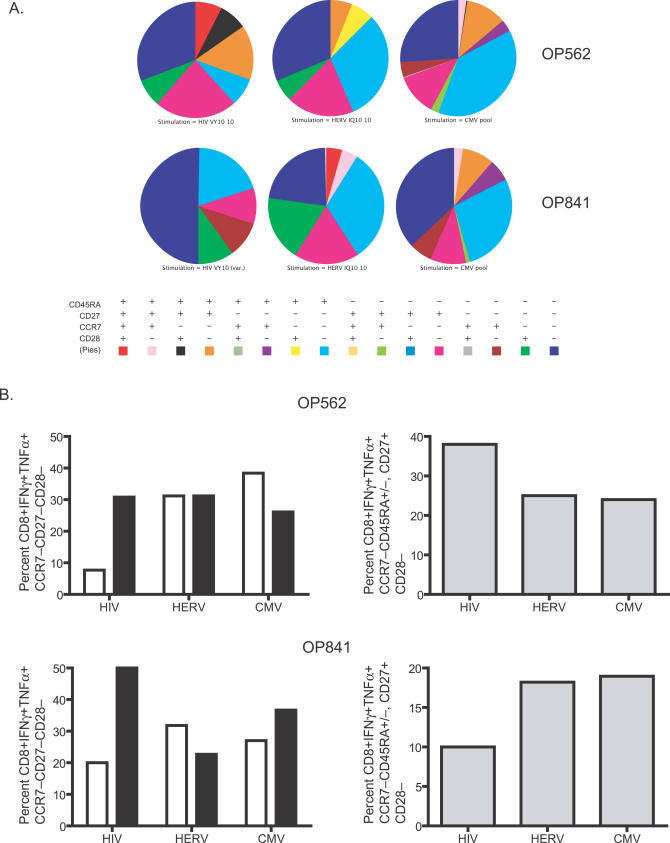
Phenotypic Profile Comparison of HIV-1-, HERV-, and CMV-Specific T Cells Measured by Multicolor Cytokine Flow Cytometry(A) Phenotypic characterization of cytokine producing cells (see Text S1) from two HIV-1-positive study participants for the markers CCR7, CD27, CD28, and CD45RA are shown as pie charts. The colors in the pie charts correspond to the phenotypic categories delineated in the table below them.(B) A subset of the data from (A) is shown, highlighting comparisons of specific phenotypes. The percentages of CD45RA+ (unfilled bars) and CD45RA− (filled bars) T cells are shown in the panels in the left column. The panels in the right column detail the percentages of CD28− T cells from the two study participants.